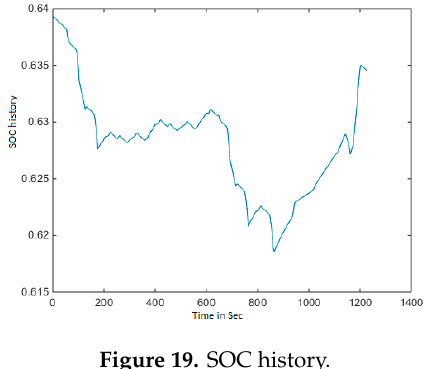
Figure 18. Energy use regeneration (regen) mode.